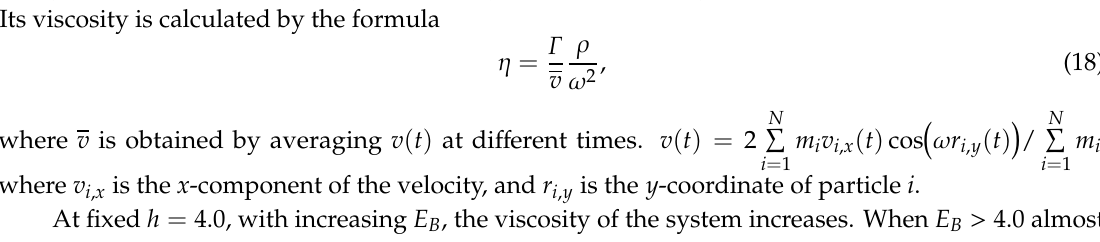
These results show the complex path-dependent phase separation behavior of SDC